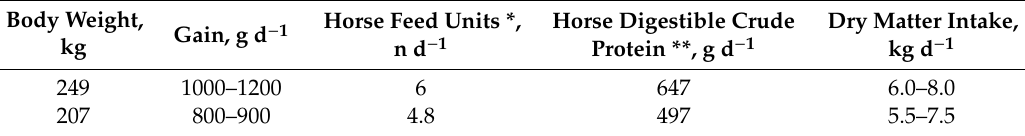
Table 4. Recommended nutrient requirements and intake for foals (600 kg adult body weight) at 3–6 months of age with a growth rate optimal or moderate